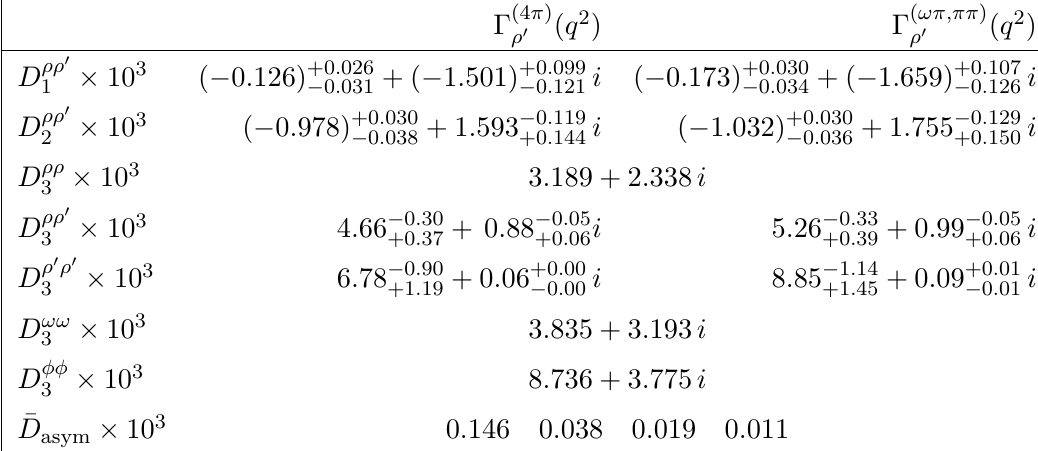
Table 5 . Numerical results for the constants defined in equation (5.12) for the two ρ 0 spectral functions Γ ρ 0 ( q 2 ) = Γ (4 π ) ( q 2 ) , equation (3.12), and Γ ρ 0 ( q 2 ) = Γ ( ωπ,ππ ) ( q 2 ) , equation (3.13). The ρ 0 ρ 0 uncertainties refer to the variation Γ ρ 0 = (400 ± 60) MeV, see appendix E, which gives the dominant √ parametric effect. ¯ D asym is given for the reference points s m ∈ { 1 . 0 , 1 . 3 , 1 . 5 , 1 . 7 }